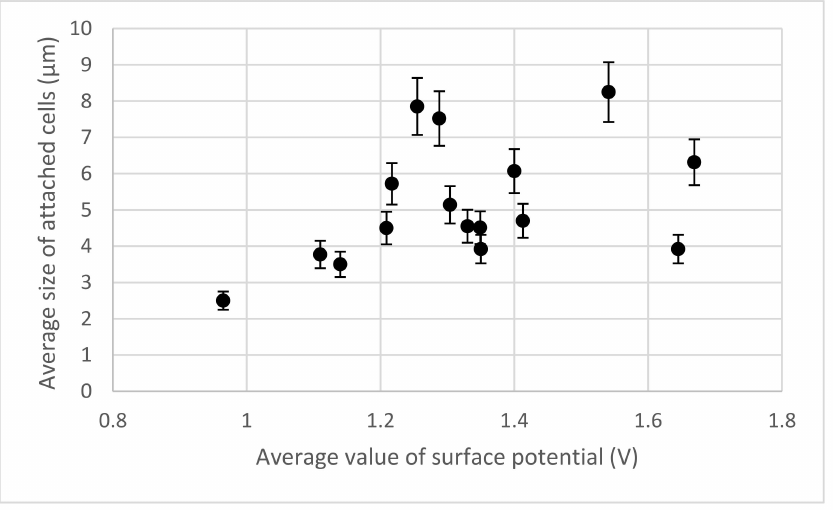
Figure 5. The correlation of the average value of surface potential and the average size of the attached cells (the vertical whiskers correspond to the standard deviation of the average size of the attached